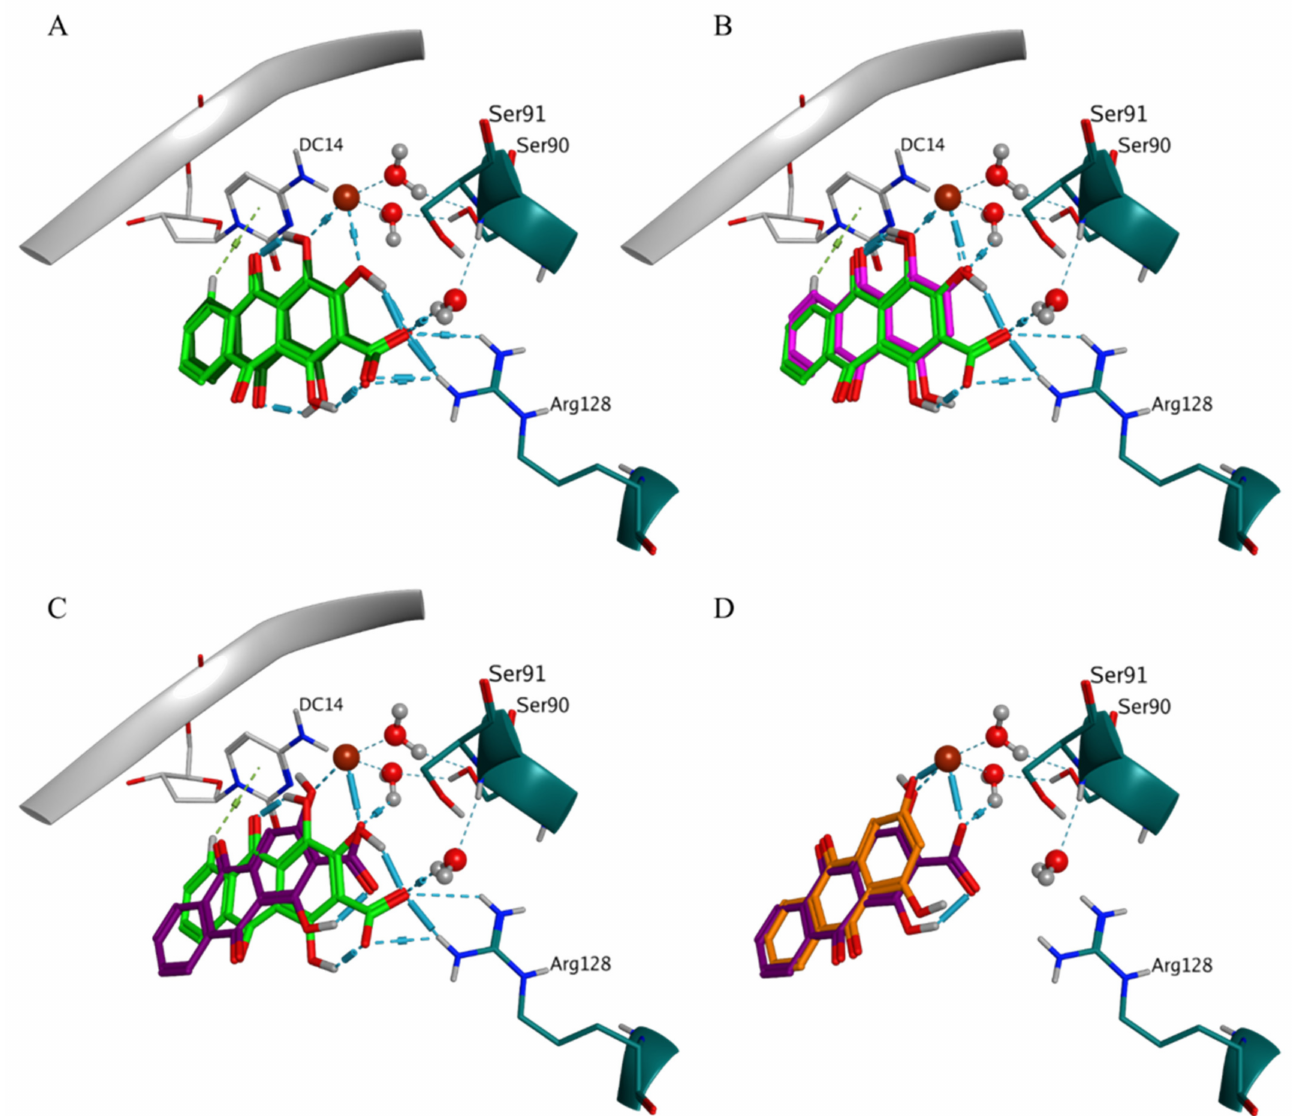
Figure 5. Binding mode 1 in the DNA gyrase complex. ( A ) comparison of the ligand-receptor interactions of two poses of pseudopurpurin (dark and light green), DC14—cytosine 14; and ( B ) com- parison of the ligand-receptor interactions of purpurin (magenta) to those of two pseudopurpurin‘s poses (green). Comparison of the ligand-receptor interactions of munjistin (dark violet) to those of: ( C ) pseudopurpurin (green) and ( D ) xanthopurpurin (orange). Mg++ is shown in brown and bridging waters are shown in atom color coding in sticks and balls